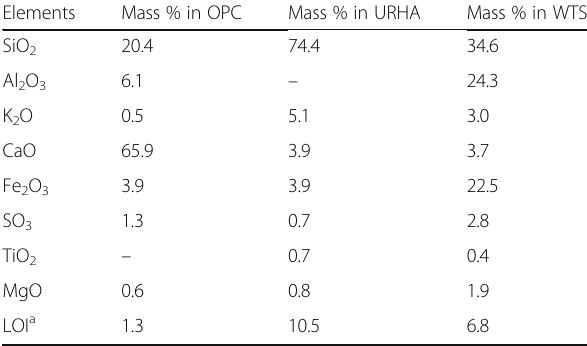
Table 1 Chemical composition of RHA and WTS